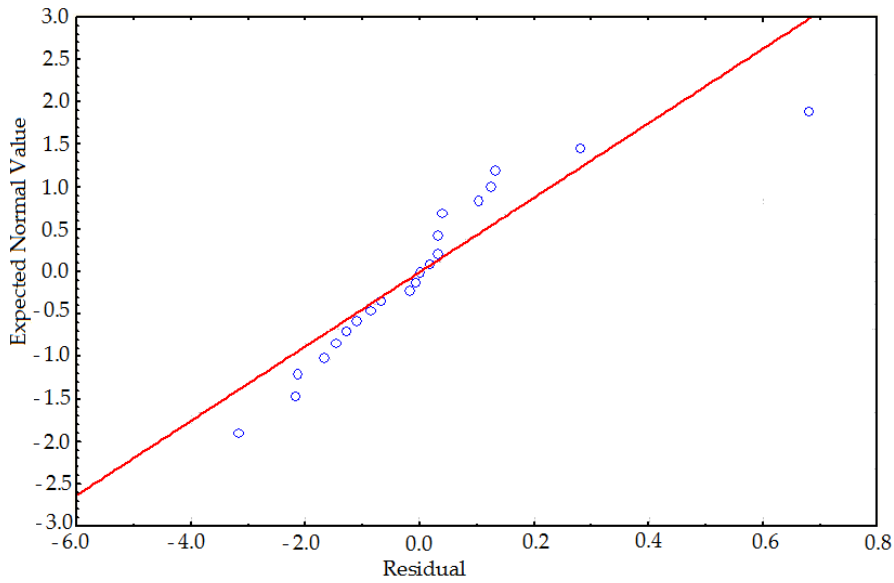
Figure 12. Normal probability plot for the CEC.